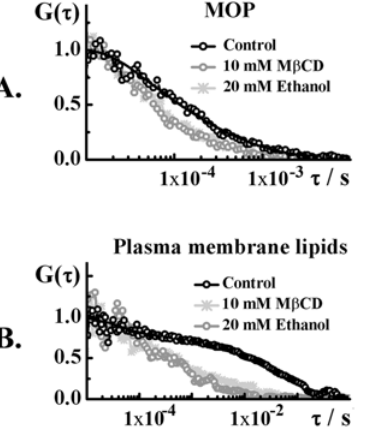
Figure 4. Effects of ethanol on the dynamics of MOP and plasma membrane lipids compared to the effects of cholester- ol depletion by M b CD. Normalized autocorrelation curves showing changes in the dynamics of A. MOP and B. plasma membrane lipids, caused by 20 mM ethanol (dark gray) or 10 mM M b CD (light gray) as compared to the dynamics in control cells (black curve).